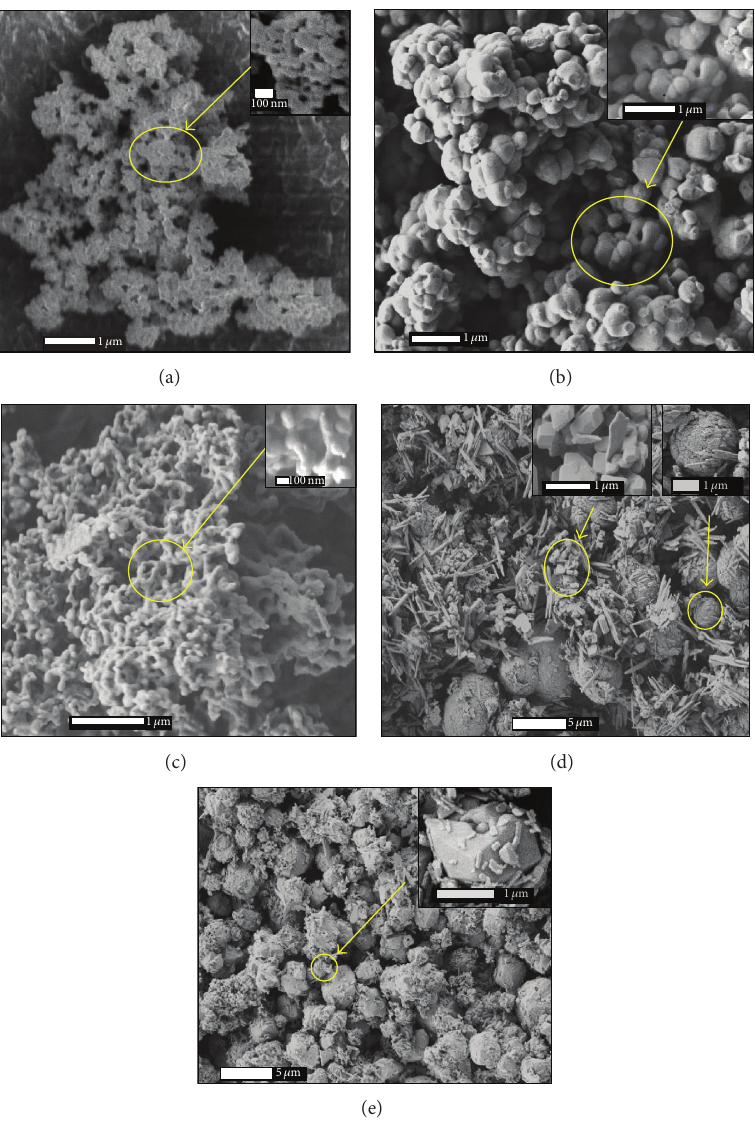
Figure 3: SEM images of BiVO 4 samples obtained from various synthesis methods: (a) coprecipitation, (b) combustion, (c) calcination, (d) hydrothermal, (e) calcination and hydrothermal